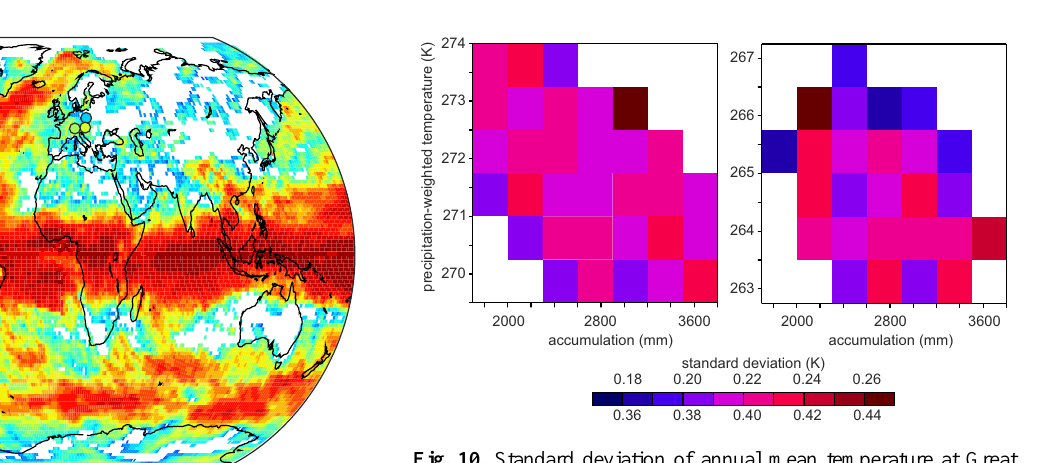
Fig. 10. Standard deviation of annual mean temperature at Great St Bernard (left, upper scale) and in 20CR at 600hPa (right, lower scale) as a function of accumulation and PWT using data from two weather generators. At least 40 points were required to calculate a standard